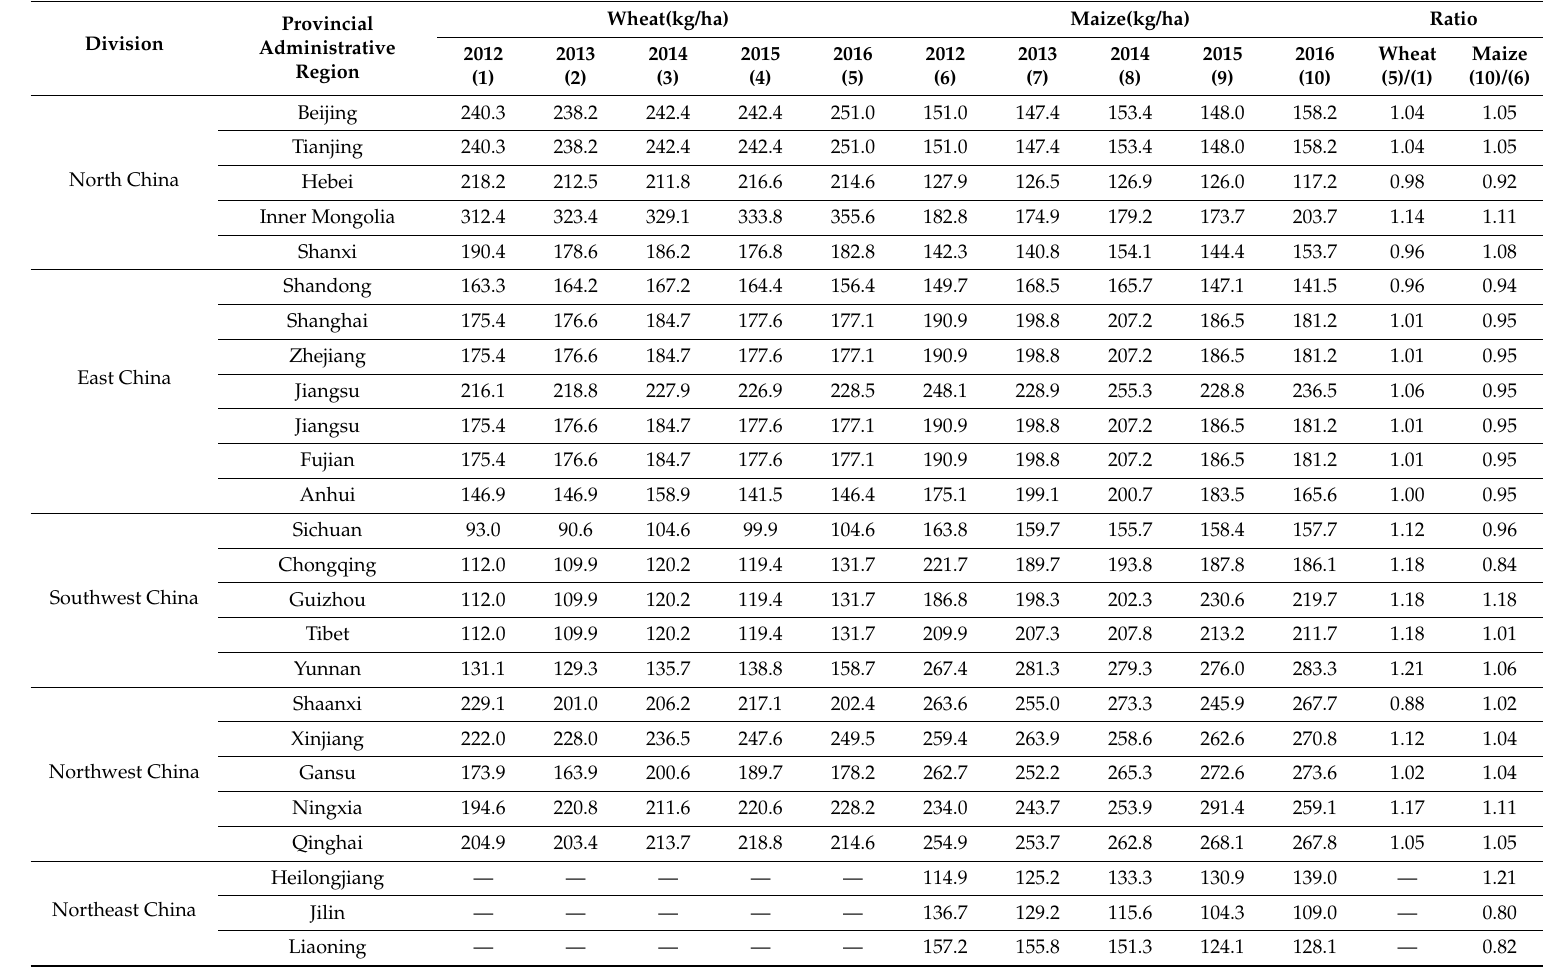
Table 3. Nitrogen application rate from 2012 to